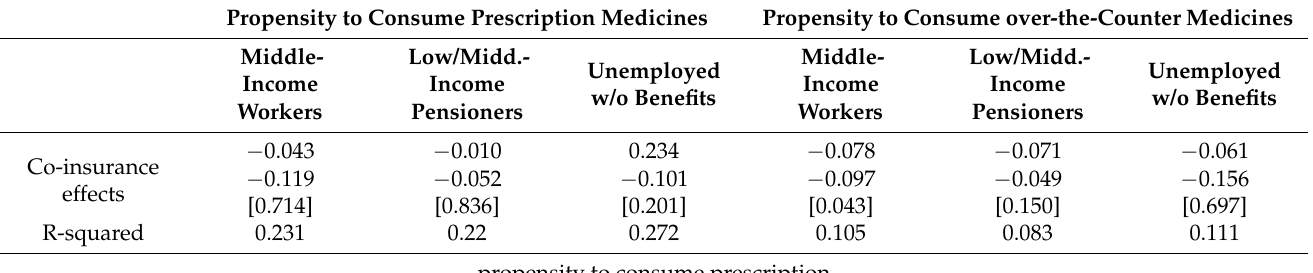
Table 8. Results for the subpopulation ‘ dependent ’ individuals and using a